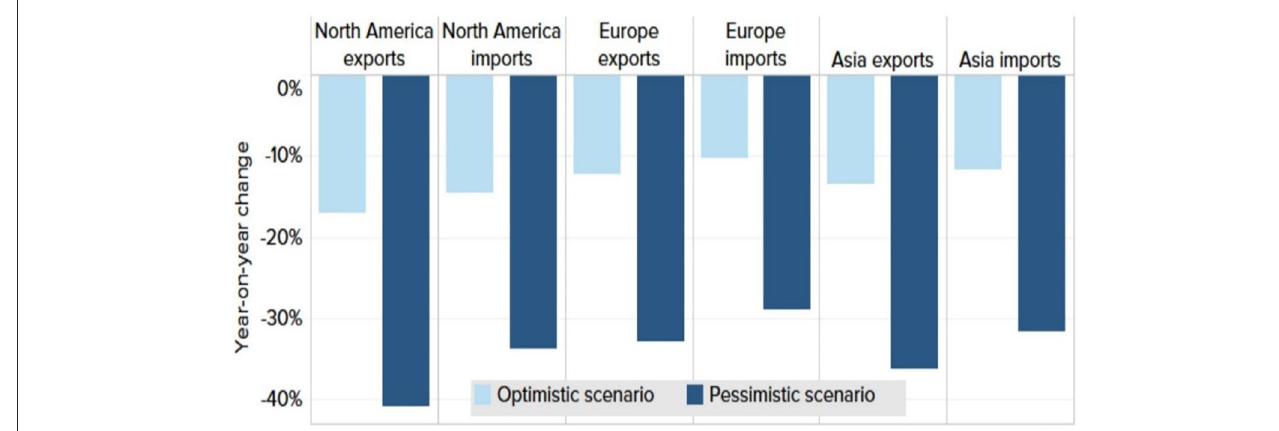
FIGURE11 Decline in merchandise trade. Source: World Trade Organization forecast.